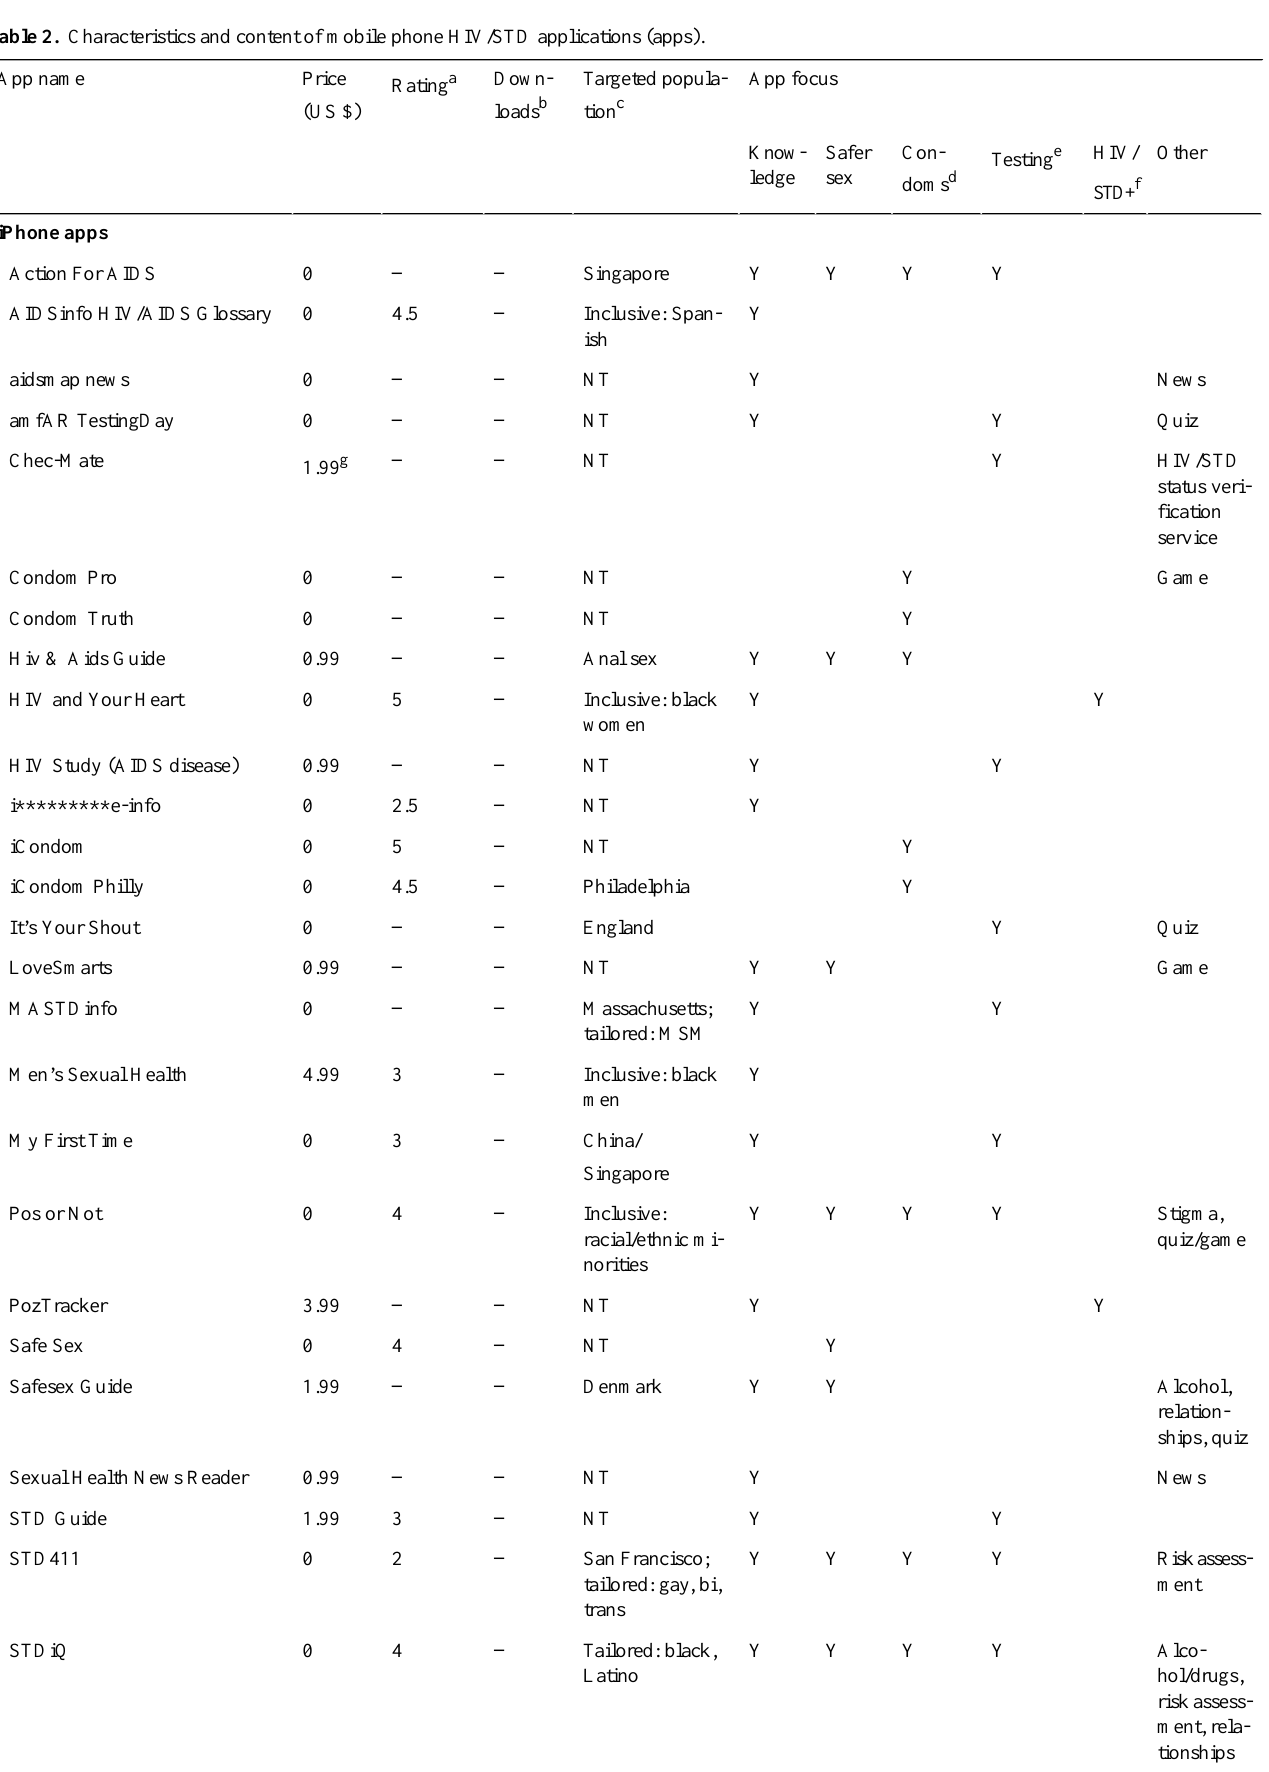
Table 2. Characteristics and content of mobile phone HIV/STD applications